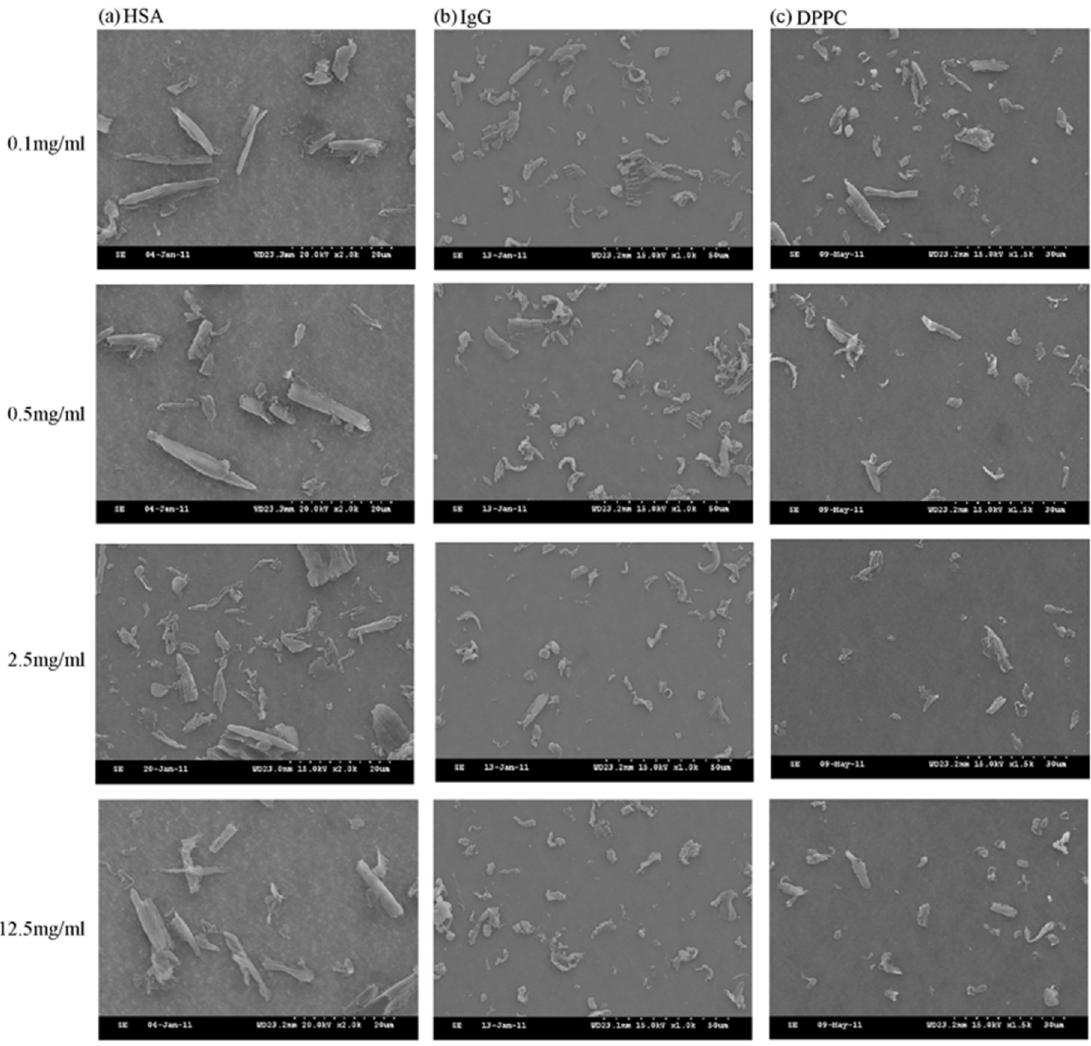
Figure 2. Morphology of PEEK wear particles under the lubrication of HSA, IgG or DPPC solution. ( a ) SEM images of the PEEK wear particles caused by rubbing PEEK pin against microfabricated surfaces in 0.1, 0.5, 2.5, and 12.5 mg/mL HSA solution (2000× magnification). ( b ) SEM images of the PEEK wear particles caused by rubbing PEEK pin against microfabricated surfaces in 0.1, 0.5, 2.5, and 12.5 mg/mL IgG solution (1000× magnification). ( c ) SEM images of the PEEK wear particles caused by rubbing PEEK pin against microfabricated surfaces in 0.1, 0.5, 2.5, and 12.5 mg/mL DPPC solution (1500× magnification).